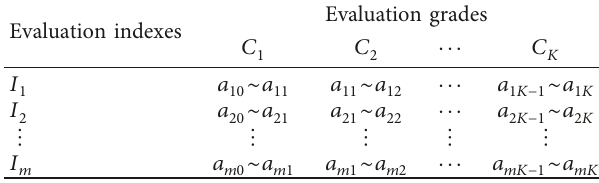
Table 1: Standard grade of every